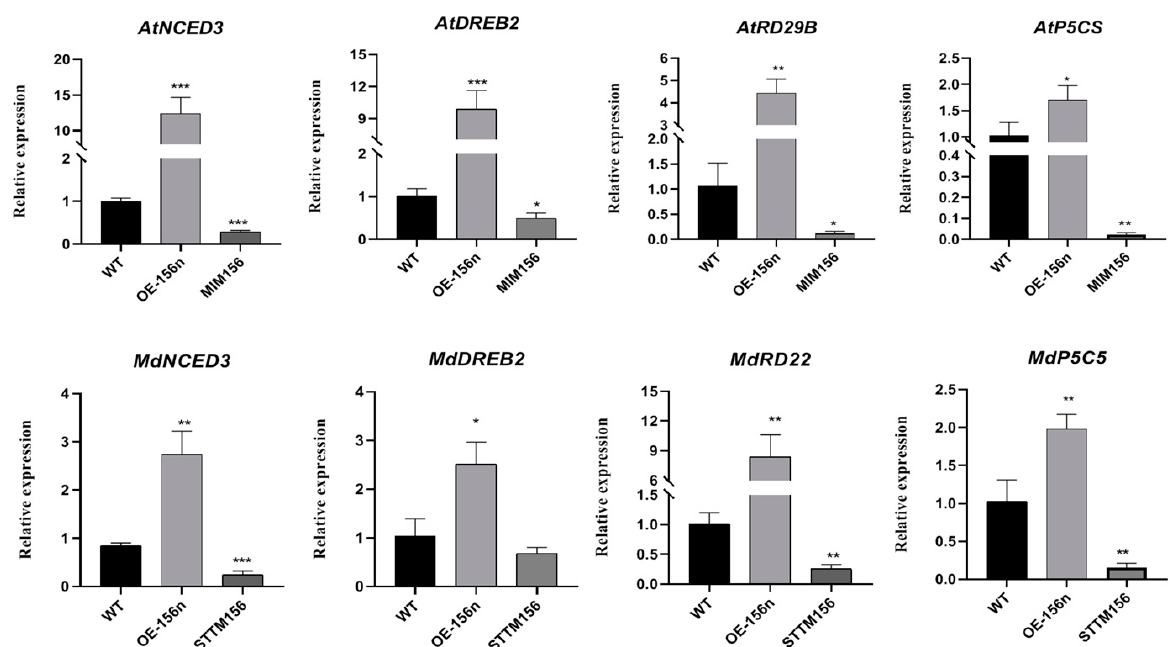
Figure 4. Expression analysis of stress-related genes in Mdmir156n transgenic A. thaliana. and apple calli under 6% PEG treatment. Values are means SD of three independent biological replicates. As- terisks indicate statistically signi fi cant di ff erences (* p < 0.05, ** p < 0.01 and *** p < 0.001, one-way ANOVA).